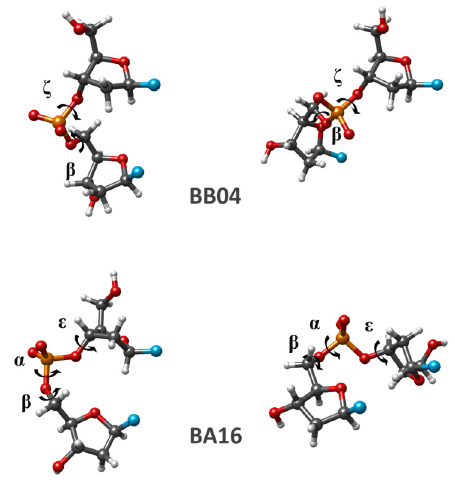
Figure 5. Two examples of major changes in SPB conformations upon DFT optimization of NtC classes deviating from the energy minima of a separate SPB fragment. Experimental ( left ) and PBE optimized ( right ) conformations. A drastic change happens in the mutual positions of glycoside bonds due to geometry optimization. Labeled torsion angles indicate those changed by more than 30° during the optimization.